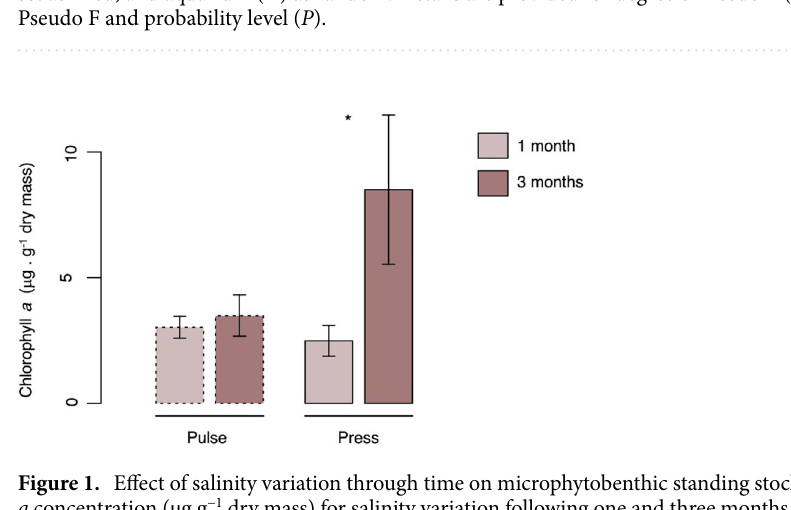
the model sets the combined mortality to a maximum of 100% 7,69 . We did not consider the source of variation